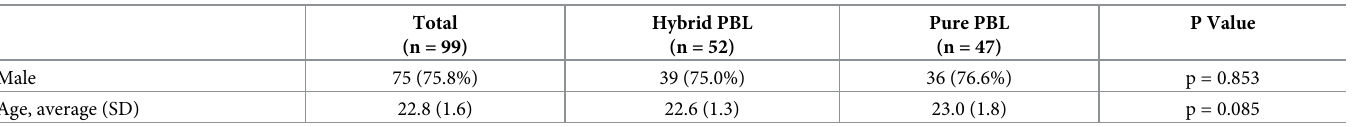
Table 2. Participant characteristics.